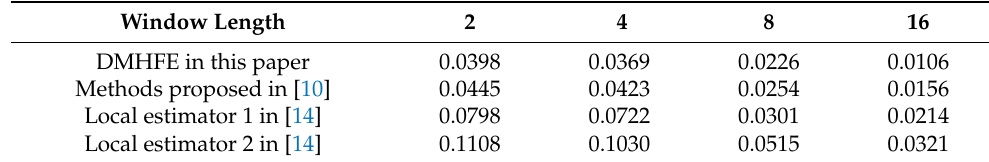
Table 2. The mean root mean square error (RMSE) of different window lengths N .